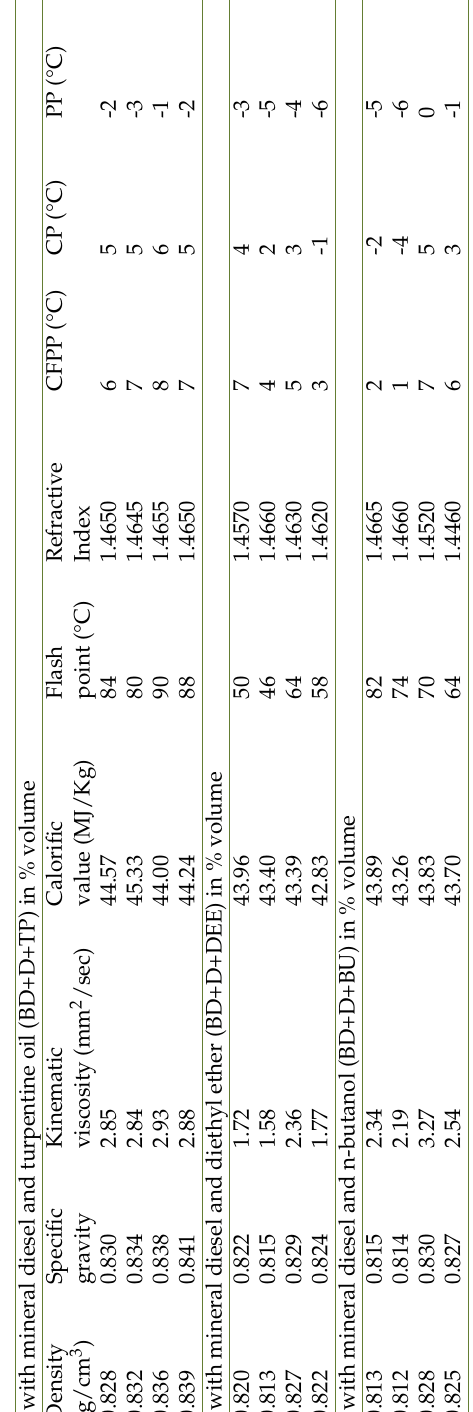
Table 6. Fatty Acid Composition of Neem Oil.